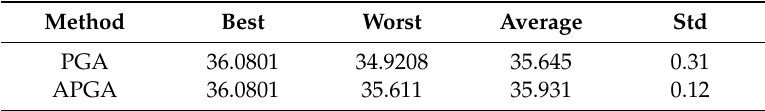
Table 7. Comparison of di ff erent methods for solving time-varying theme park routing (TDTPRP) (28